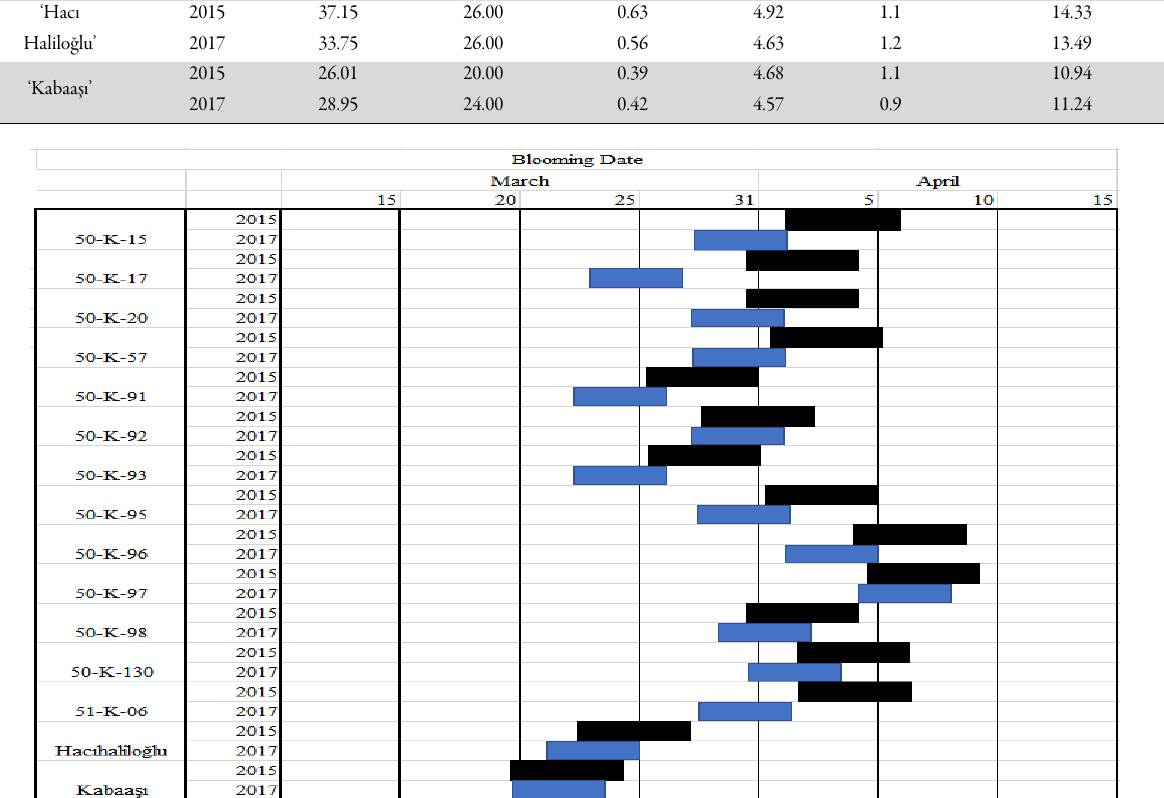
Table 2. The average values of pomological analysis of apricot types (2015-2017) Genotypes ‘50-K-15’ ‘50-K-17’ ‘50-K-20’ ‘50-K-57’ ‘50-K-91’ ‘50-K-92’ ‘50-K-93’ ‘50-K-95’ ‘50-K-96’ ‘50-K-97’ ‘50-K-98’ ‘51-K-06’